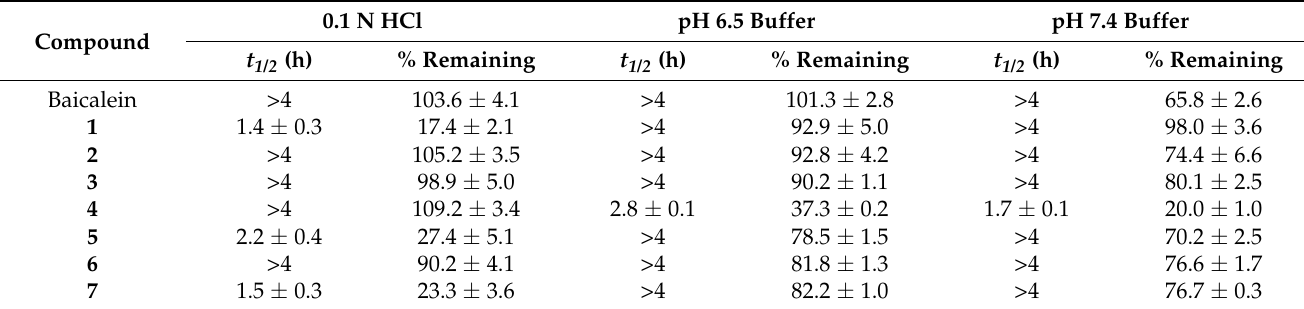
Table 1. Chemical stability of baicalein and its carbamate prodrugs in physiologically-relevant solutions. Compound